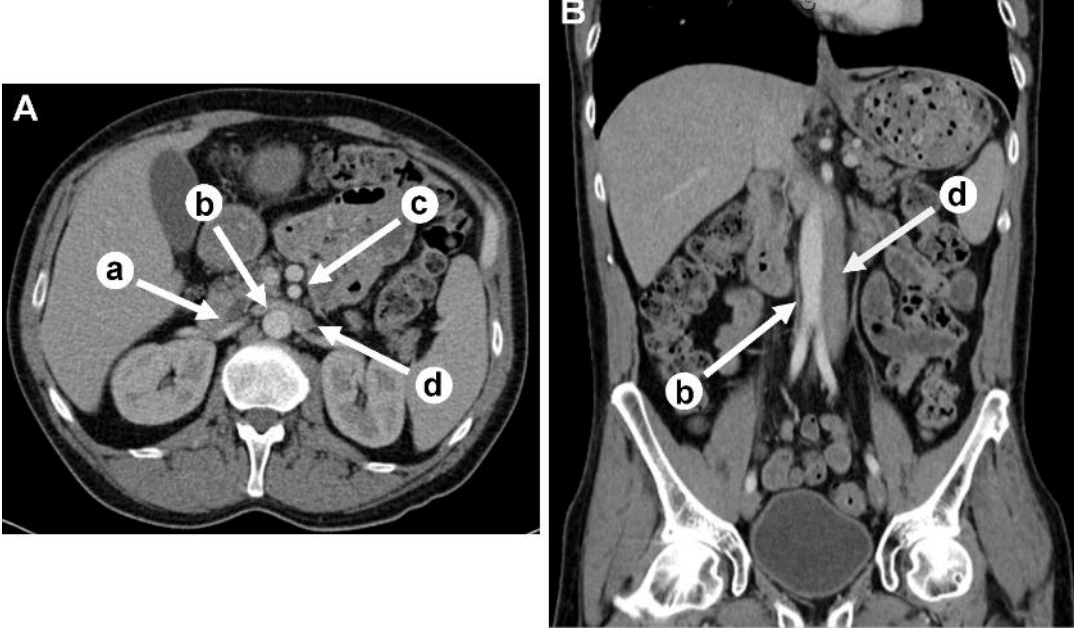
FIGURE 1. (A) Axial CT of the abdomen with contrast and (B) coronal reconstruction demonstrating the inverted nutcracker syndrome. a = Right renal vein, b = right-sided aorta, c = superior mesenteric artery, d = left-sided vena